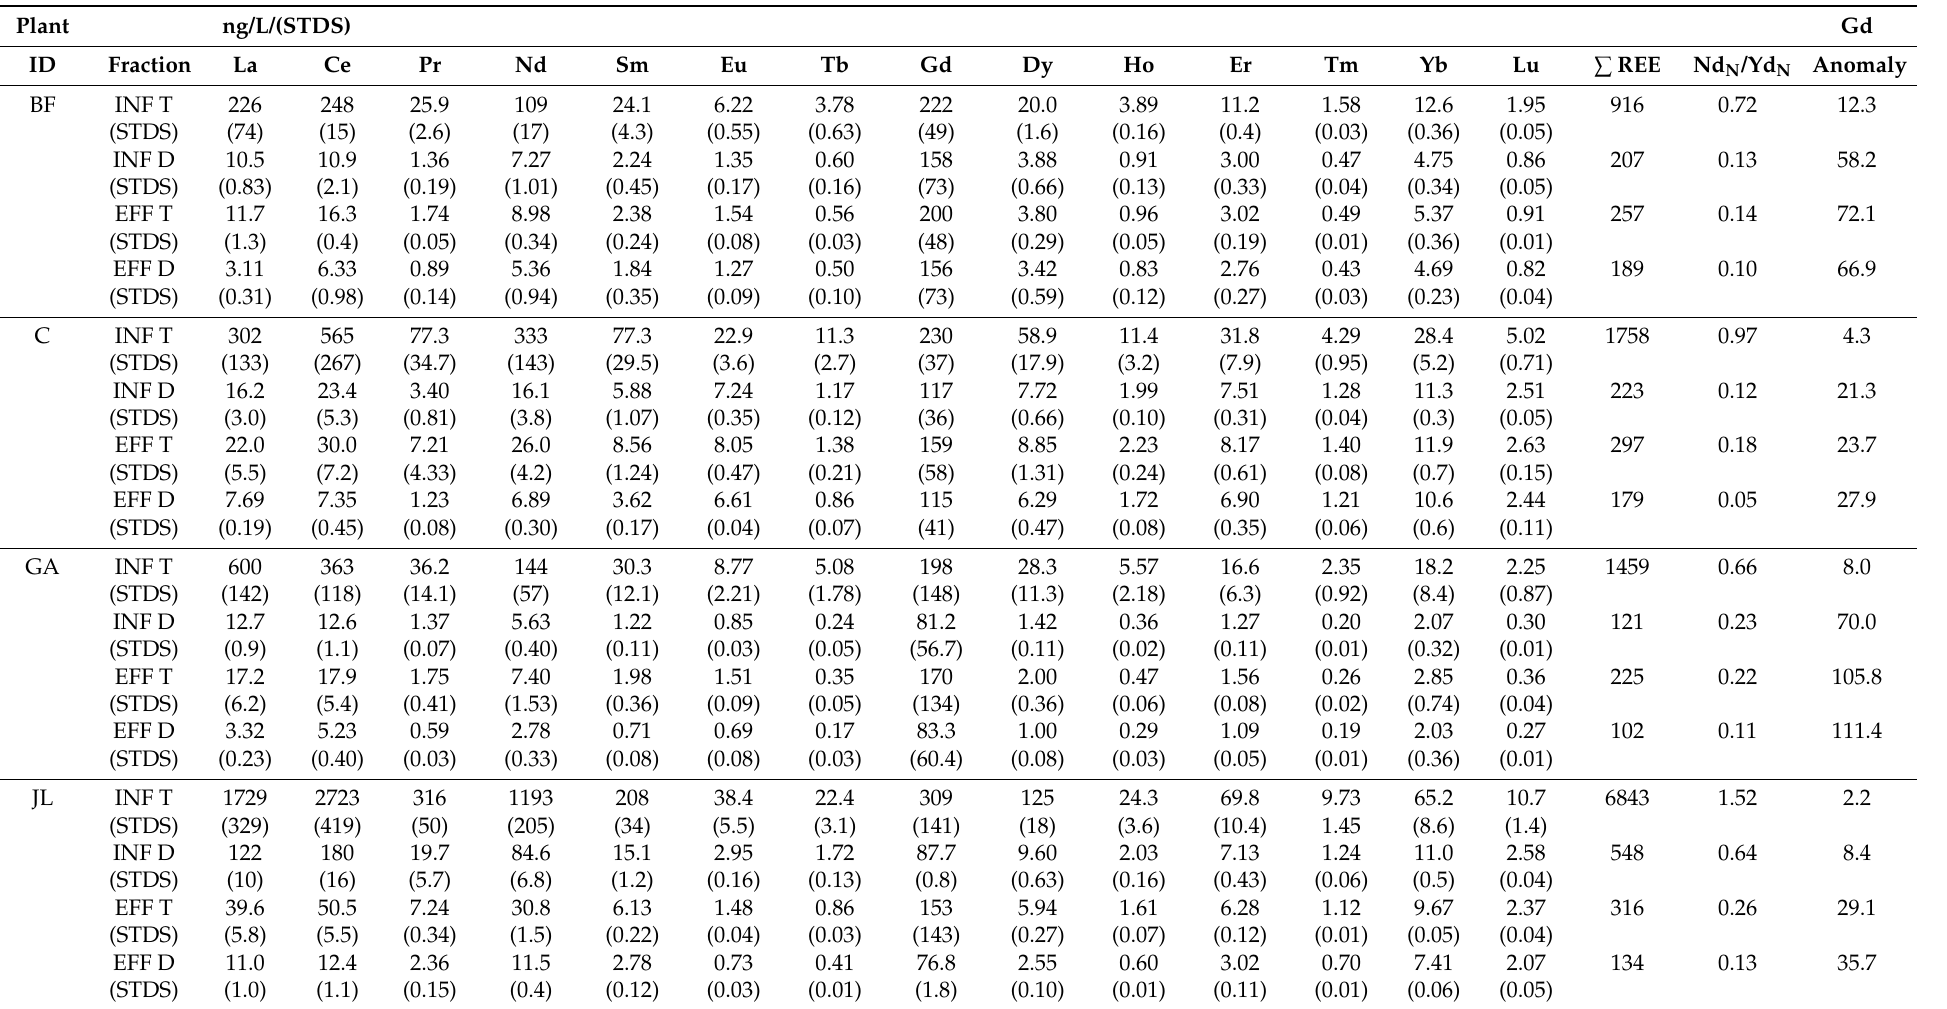
Table 3. REE concentrations in total (T) and dissolved phase (D) of wastewater influents (INF) and effluents (EFF) ( n = 3) from six treatment plants in Canada. Gadolinium anomaly calculations in wastewater and ratio Nd N /Yd N